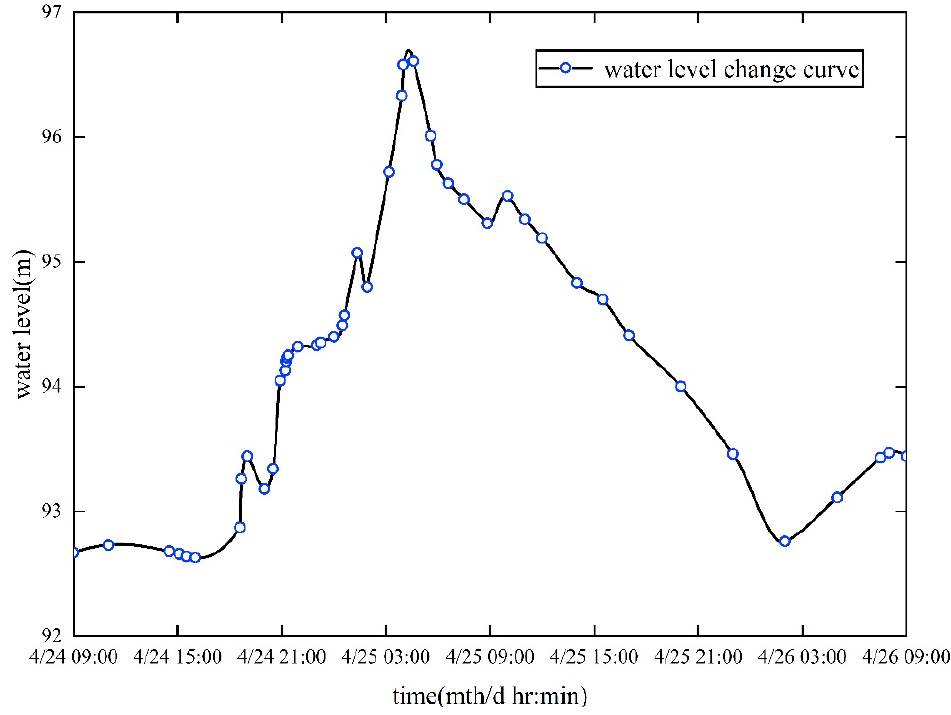
Figure 8. Water level change chart.